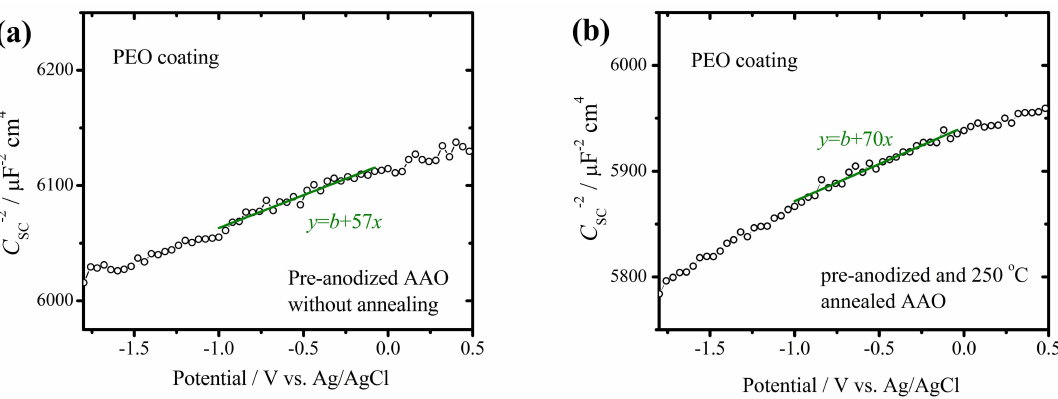
Figure 7. Typical Mott-Schottky plots of the PEO coatings. The plots of C SC − 2 versus electrode potential are drawn for the PEO coatings with an AAO layer ( a ) without annealing, ( b ) 250 ◦ C annealing.